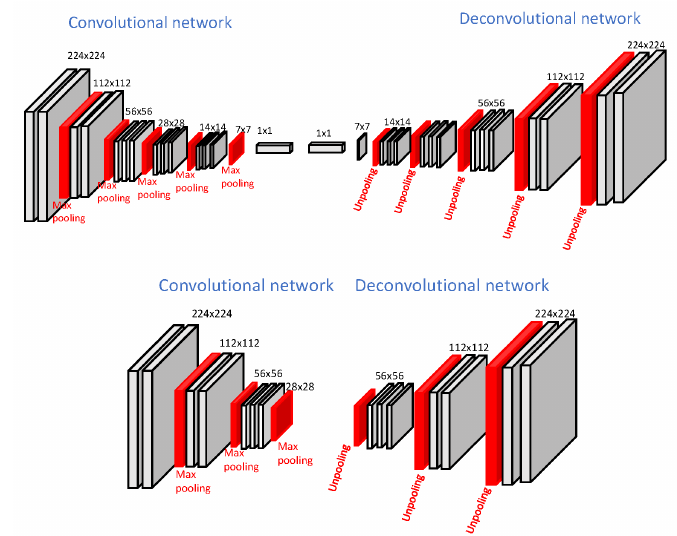
Figure 9. Top : Original DeconvNet architecture, Bottom : Proposed light-weight network architecture (images obtained from [17]).